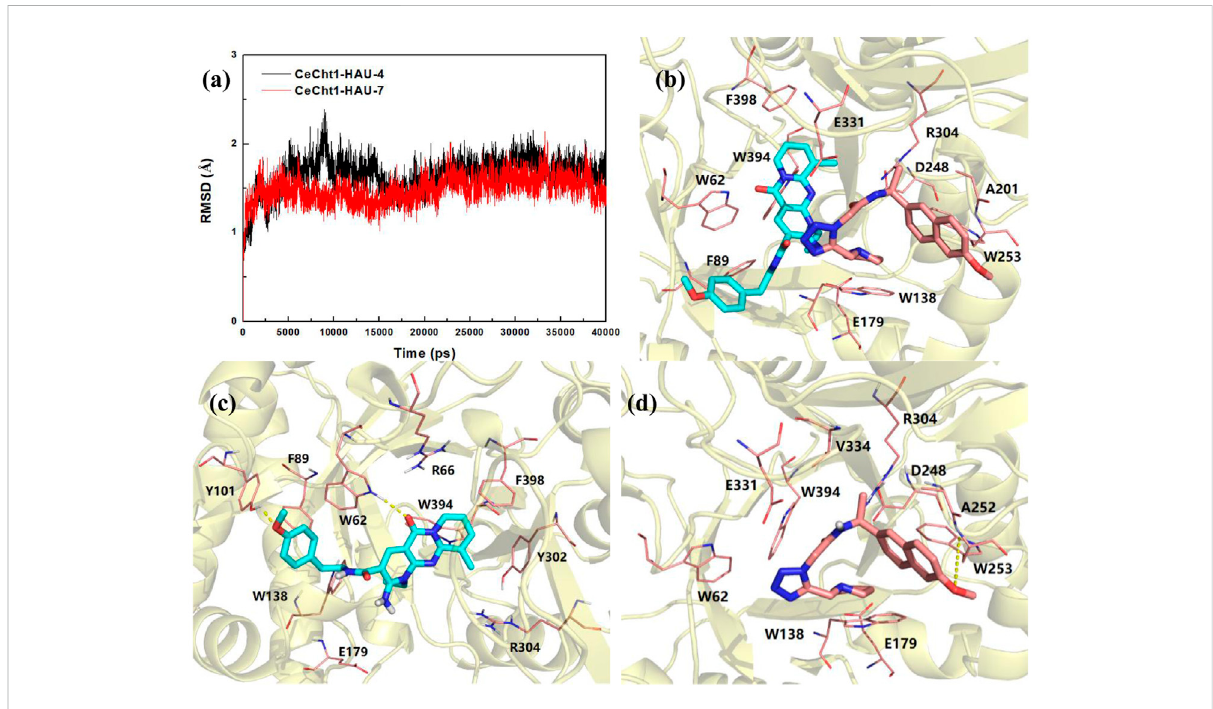
FIGURE 4 (A) RMSD changes of compounds HAU-4 and HAU-7 in complex with Ce Cht1. (B) Superimposition of the conformations of HAU-4 and HAU-7 in Ce Cht1 pocket at 40 ns MD simulations. Speci fi c binding conformations of (C) Ce Cht1 -HAU-4 and (D) Ce Cht1- HAU-7 systems revealed by MD simulations. Compound HAU-4 is shown in cyan; HAU-7 is shown in pink. Colored according to